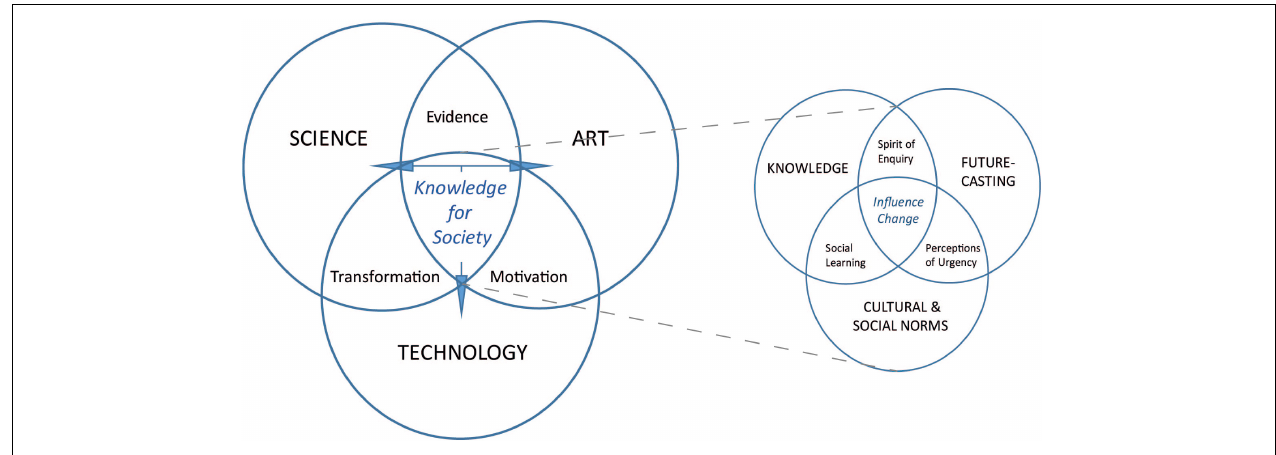
FIGURE 6 | A model of knowledge generation that is responsive to the needs of society and allows reciprocity and exchange between and within disciplines.